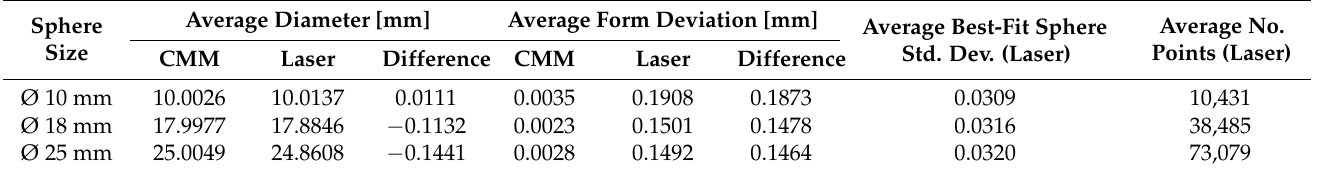
Table 1. Measurement results of the original (pre-sandblasted) spheres.